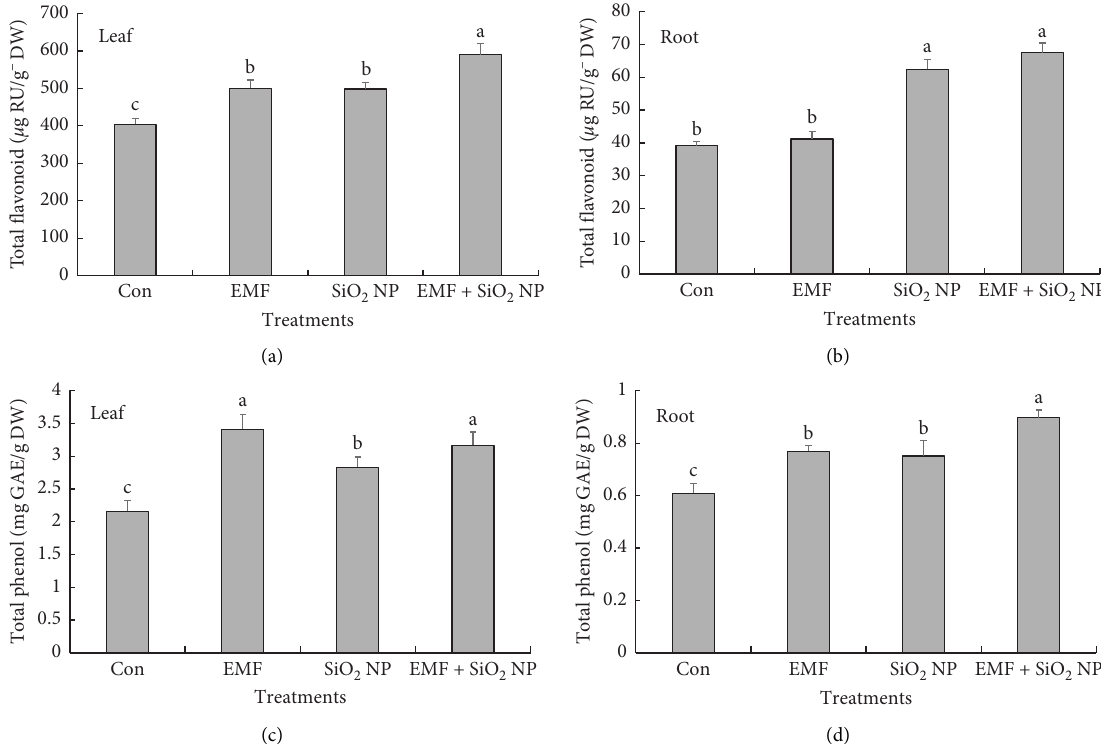
Figure 5: Changes in flavonoid (a, b) and phenol (c, d) contents in A. gilanica plants under EMF and SiO means ± SE ( n � 3) in each group. Different letters indicate significant differences at P ≤ 0 .